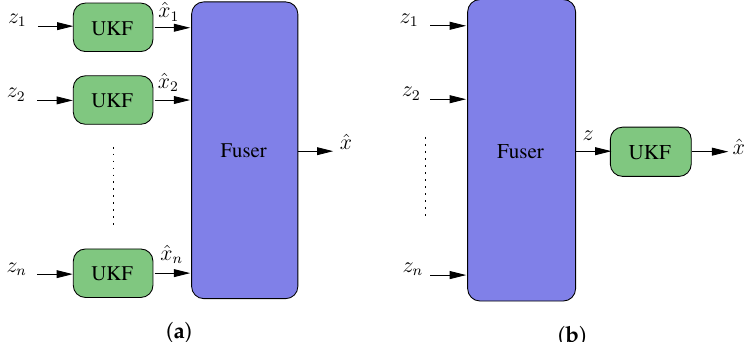
Figure 16. Block diagram for two fusion philosophies: ( a ) Merging of the estimated state vector, which requires a filtering stage for each measure to be merged; and ( b ) merging of observations under a given criterion and subsequent